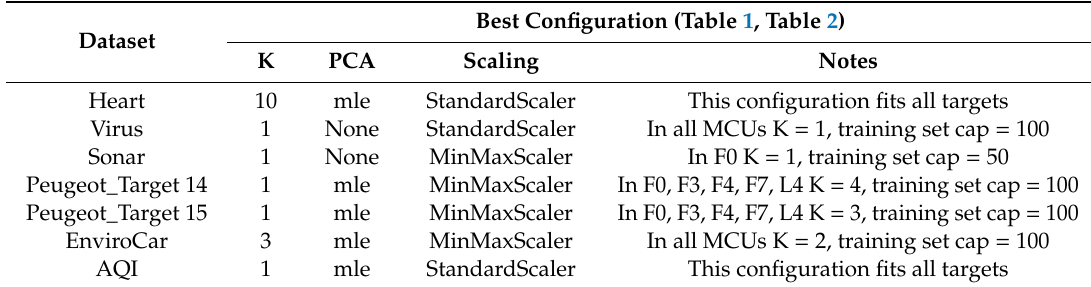
Table 11. k-NN corresponding configurations.